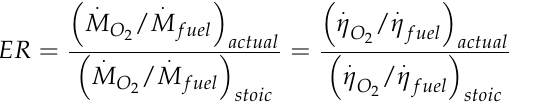
Figure 2. Profiles of solid concentrations with different grid sizes.